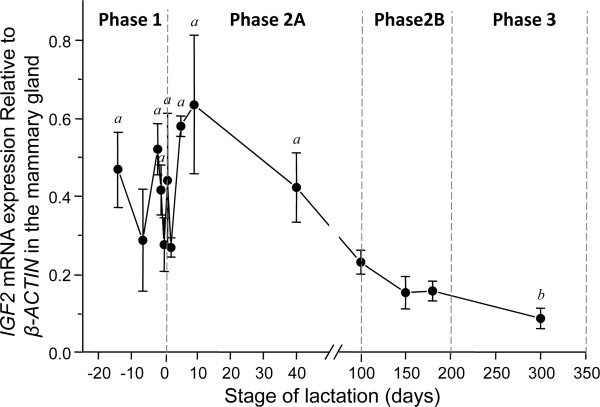
 IGF2mRNA expression relative toβ-ACTINmRNA expression in the mammary gland.IGF2 mRNA expression (mean ± standard error of the mean) compared with β-ACTIN expression in the mammary gland across the four phases of lactation. IGF2 was highest in the perinatal period, but steadily decreased throughout the remainder of lactation. a significantly higher than b(P < 0.05). IGF, insulin-like growth factor.